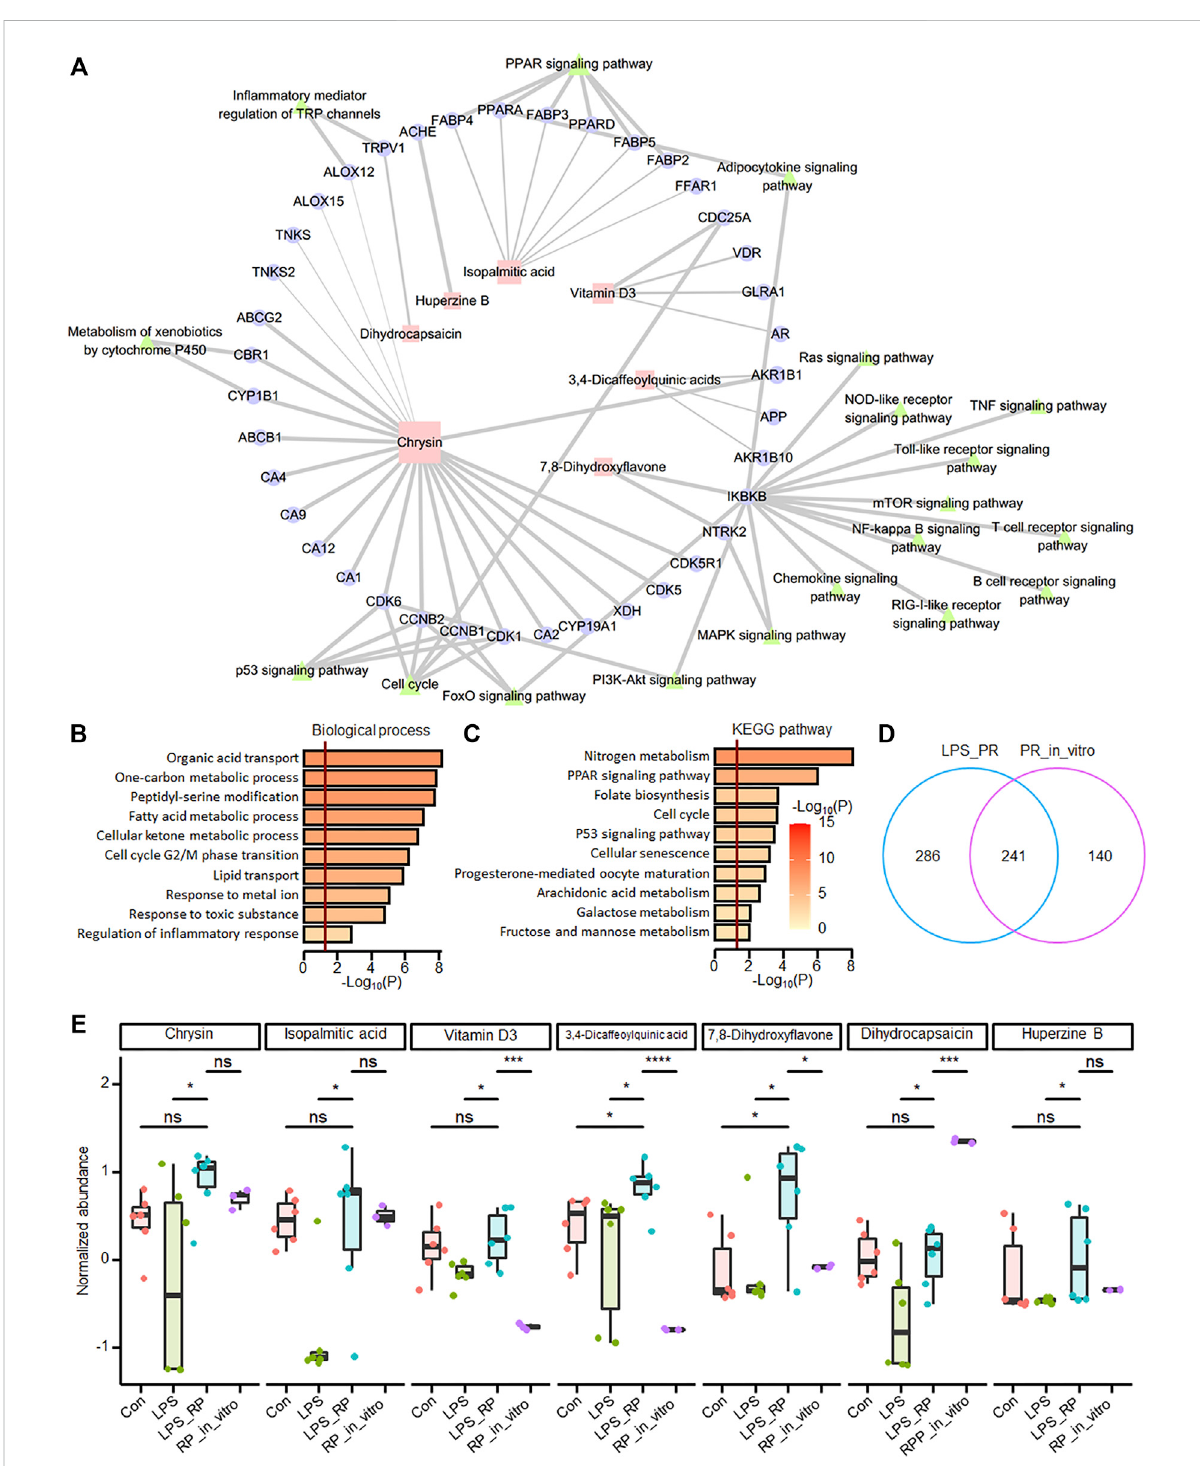
FIGURE 5 Network pharmacological analysis showed that potential anti-in fl ammatory ingredients are found in PR. (A) PR network pharmacology. 39 targets of seven metabolites and KEGG pathways closely related to in fl ammation were displayed in the network. Squares represent metabolites, circles represent potential targets, and triangles represent KEGG pathways. The size of the shape is positively correlated with the degree, and the thickness of the line is positively correlated with probability. (B) Functional enrichment results of targets of differentially expressed metabolites. (C) Pathway enrichment results of targets of differentially expressed metabolites. The darker the color, the more signi fi cant the p value. The red vertical bar indicates that p value is 0.05. (D) overlap of identi fi ed metabolites in LPS_PR and PR in vitro . (E) Abundance of seven metabolites in four groups in Con, LPS, LPS_PR and PR in vitro . Welch ’ s t -test was performed for compare the expression differences of metabolites between each two groups. *p < 0.05 , **p < 0.01 , ***p < 0.001 , ****p <